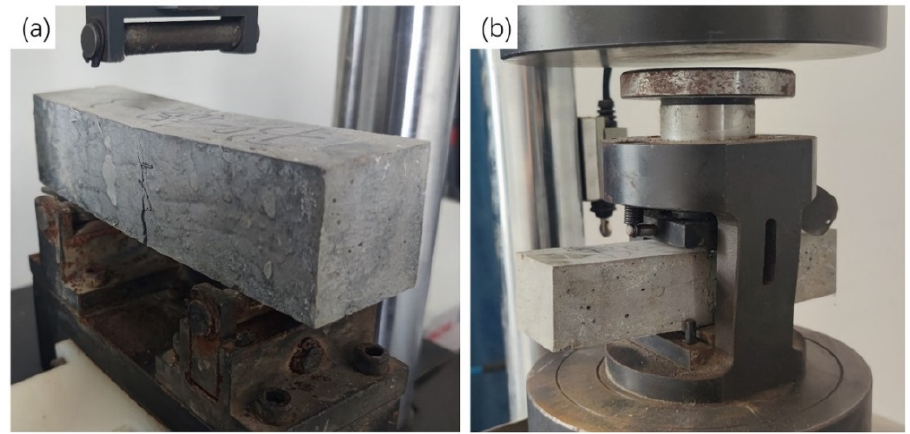
Figure 4. Three samples were used for each test.